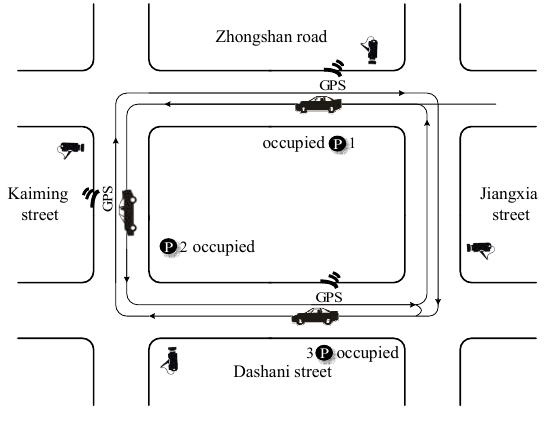
Figure 1. Investigation plan.